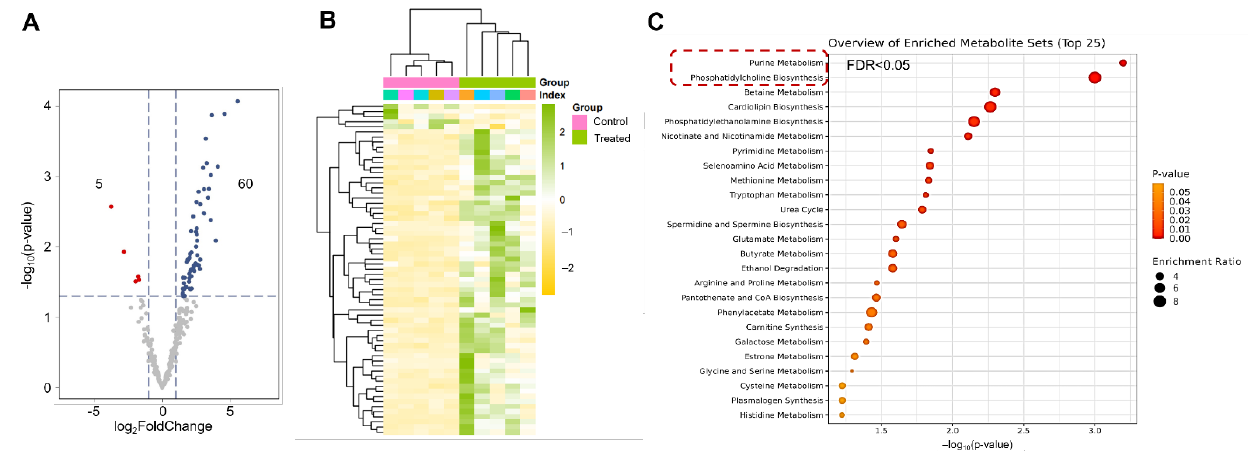
Figure 8. ( A ). Volcano plot of metabolite profiles dependent on log 2 FoldChange ( n = 5 replicates per group). Red dots are presented as downregulated metabolites, and blue dots are presented as upregulated metabolites (threshold value |log 2 FoldChange| > 1.0 and FDR q-value < 0.05). Intervention dosage is set as 1.0 J/cm 2 . ( B ). Heatmap shows abundance of significant difference in metabolites post intervention compared with the control group. Five parallels per group. Clustering was conducted at row and column levels. ( C ). Metabolism pathways on significantly upregulated metabolites ( p < 0.05 and FDR q-value < 0.05) in control and treatment groups obtained from MetaboAnalyst website.